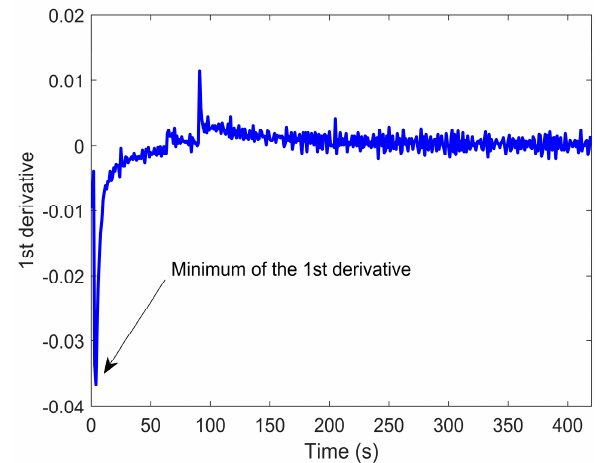
Figure 2. The fifth feature has been extracted from the first derivative of the signal and is the minimum value of the derivative itself.